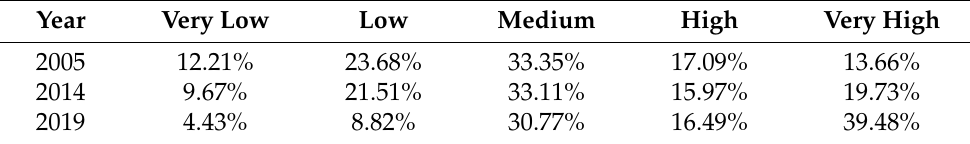
Table A4. Changes in the percentage of the different hazard levels from 2005–2019 (%).